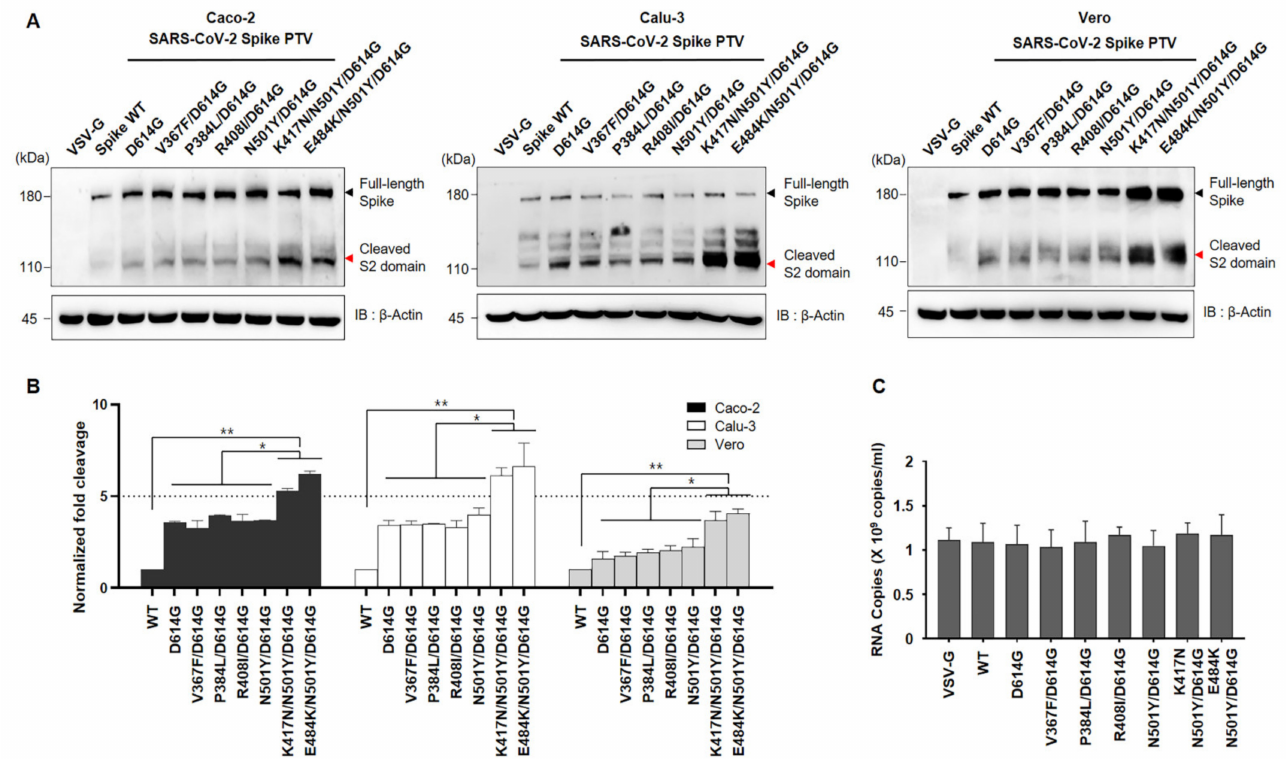
Figure 3. Effect of RBD mutation on spike cleavage ( A ) Murine leukemia virus (MLV) particles bearing VSV-G, SARS-CoV-2 spike (WT), SARS-CoV-2 Wuhan Spike (D614G, V367F/D614G, P384L/D614G, or R408I/D614G), or SARS-CoV-2 B.1.351 spike (N501Y, K417N/N501Y.D614G, or E484K/N501Y/D614G) were infected into indicated cell lines. Then cells were lysed and an equal amount of total proteins were analyzed by immunoblotting using an anti-SARS-CoV-2 Spike S2 domain antibody. ( B ) The measuring of band intensity of cleaved spike S2 domain (~100 kDa) and full-length spike (~180 kDa) was determined by semi-quantification of immunoblotting (IB), followed by calculated cleavage rate of each spike variants compared with Spike WT. ( C ) The titer of each pseudovirus used in the experiment as shown in Figure 3A was quantified by RT-qPCR. Data represent the mean ± SEM. Statistical analysis was conducted using a two-tailed Student’s t -test. *, p < 0.05; **, p <